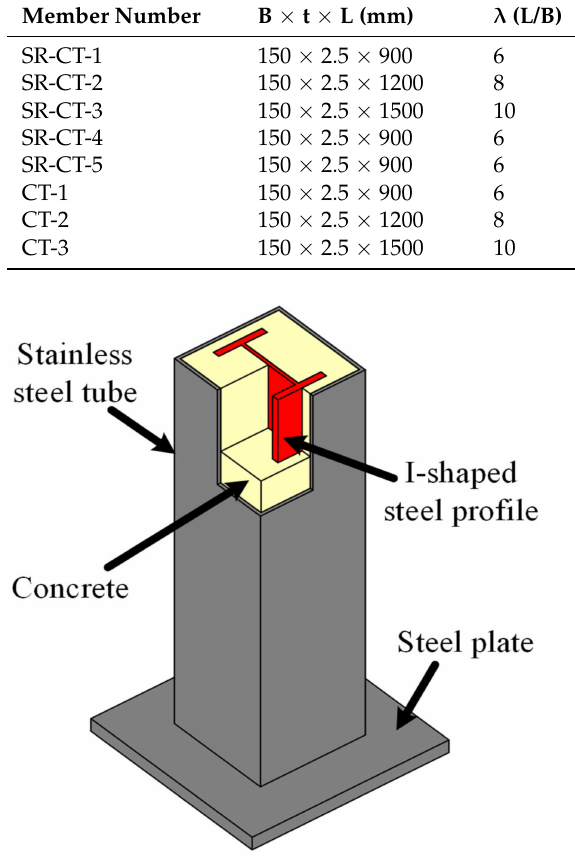
Figure 1. Three-dimensional schematic diagram of components.